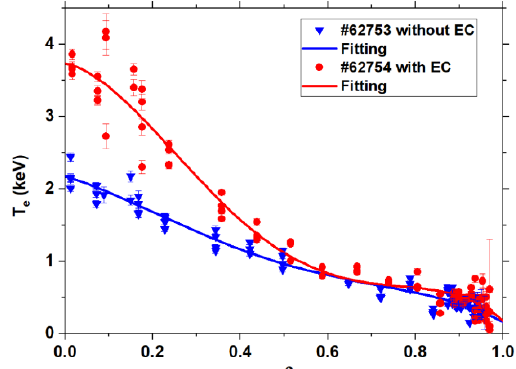
Fig. 10. Comparison of electron temperature profiles with and without ECRH.